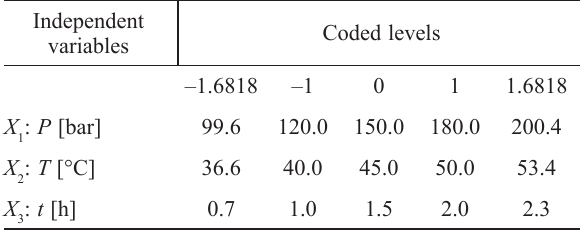
Table 1 – Operating conditions in Maqui berries extractions Independent